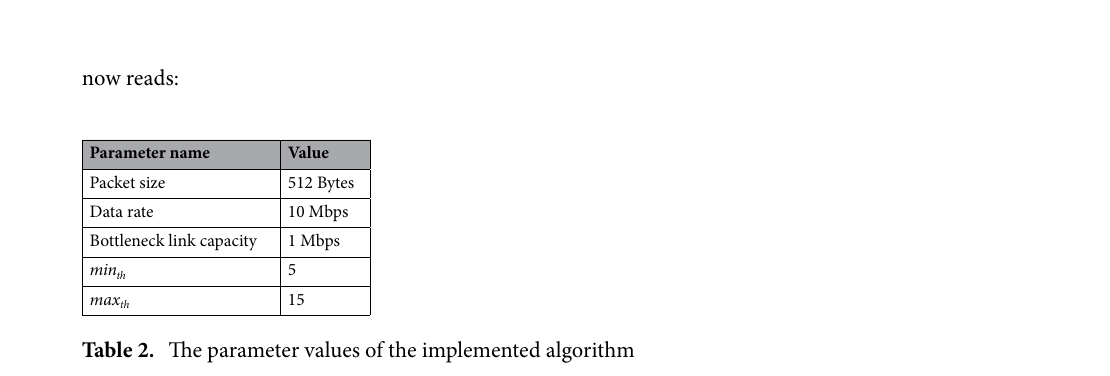
Table 2. The parameter values of the implemented algorithm